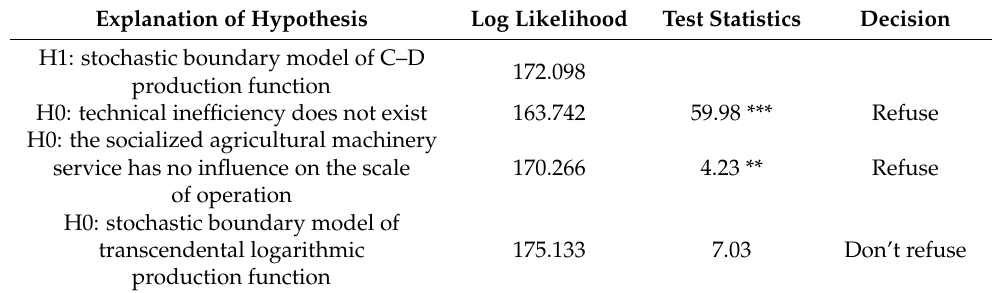
Table 3. Hypothesis test of random boundary model of Cobb–Douglas (C–D) production